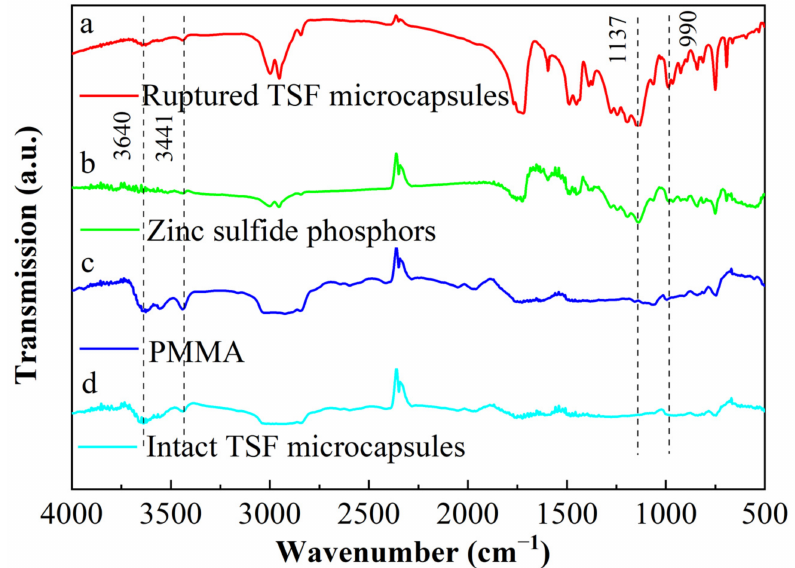
Figure 2. Fourier infrared spectrum: (a) ruptured TSF microcapsules; (b) zinc sulfide phosphors; (c) PMMA; (d) intact TSF